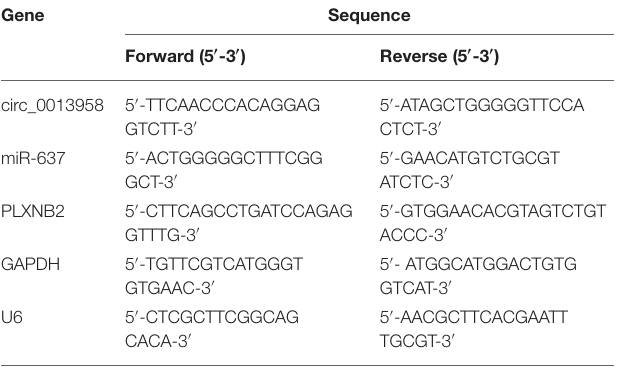
TABLE 1 | The primer sequences for qRT-PCR assay in this study.